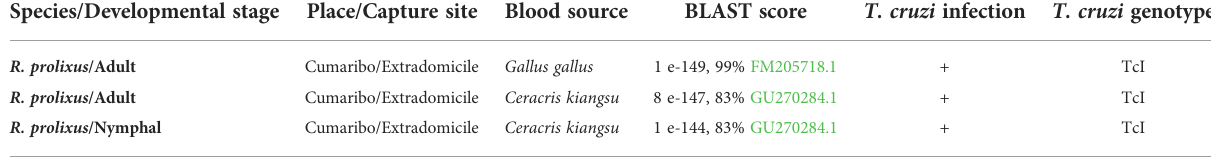
TABLE 2 Stage, capture site, blood meals, GenBank accession number, infection state, and identity (%) with the reference genotype. Species/Developmental